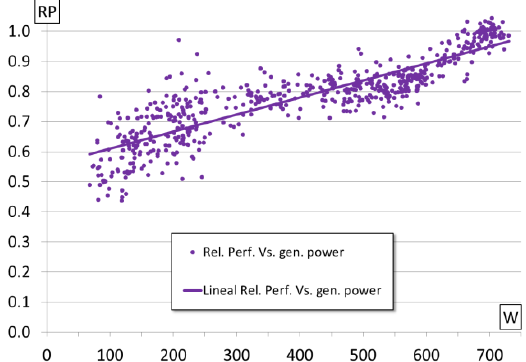
Figure 11. Relative performance of the turbine as a function of generated power and its linear regression.